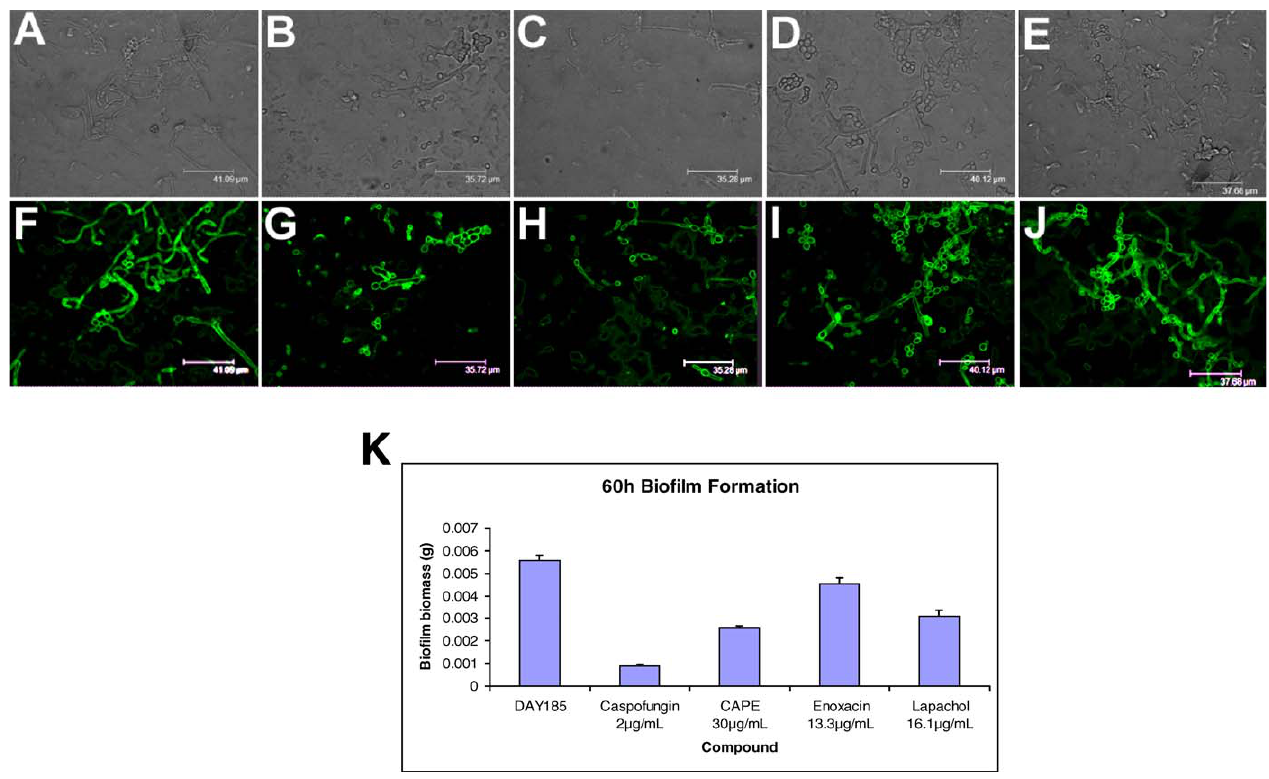
Figure 10. In Vitro Efficacy of CAPE, Enoxacin, and Lapachol in Biofilm Formation DAY185 formed biofilms on silicone squares in the presence of DMSO in PBS (A and F), caspofungin (B and G), CAPE (C and H), enoxacin (D and I), or lapachol (E and J). Silicone squares were observed for filament formation with a 40 3 oil emersion objective (A–E) and stained with concanavalin A-Alexa 488 to identify the cell membranes of DAY185 with confocal microscopy (F–J). All three compounds significantly decreased the dry mass of the silicone pads ( p ¼ 0.020 for caspofungin, CAPE, and lapachol; and p ¼ 0.029 for enoxacin compared to DMSO in PBS control)